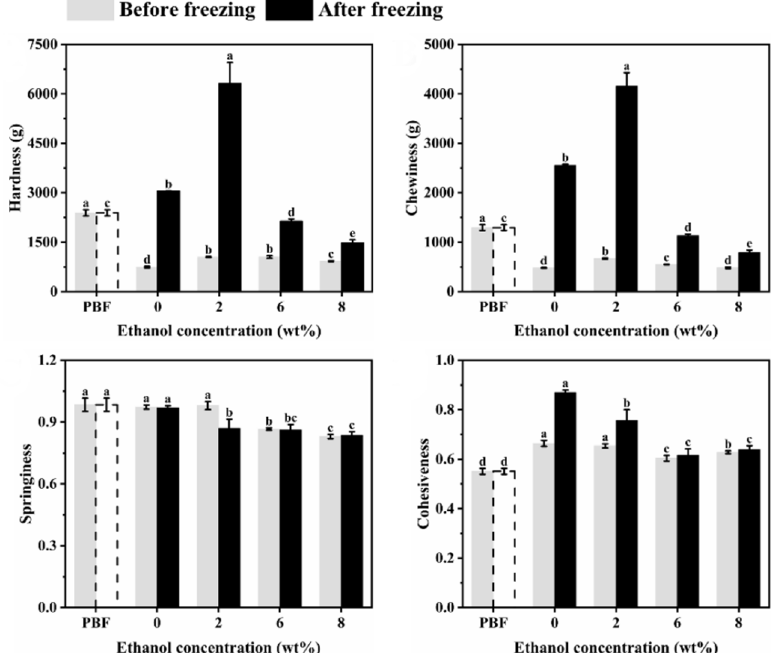
Figure 1. Textural profiles analysis (TPA) of pork backfat (PBF) and konjac emulgel-based fat analogue (KGFA) with different ethanol content before and after freeze-thaw treatment. Dotted line indicates that PBF was not frozen. Different letters indicate significant differences in columns of the same color ( p < 0.05).